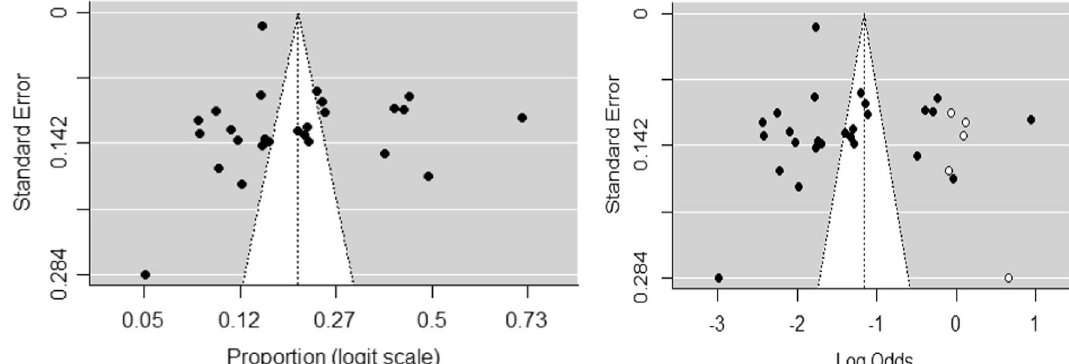
Fig. 4 Funnel (right-A) and missed study funnel plot (left-B) of the logit-prevalence of FMD in cattle in Ethiopia. It shows the number of studies missing from a meta-analysis due to the suppression of the most extreme results on one side of the funnel plot; it augments the observed data, so the funnel plot is more symmetric (white circle are augmented data)